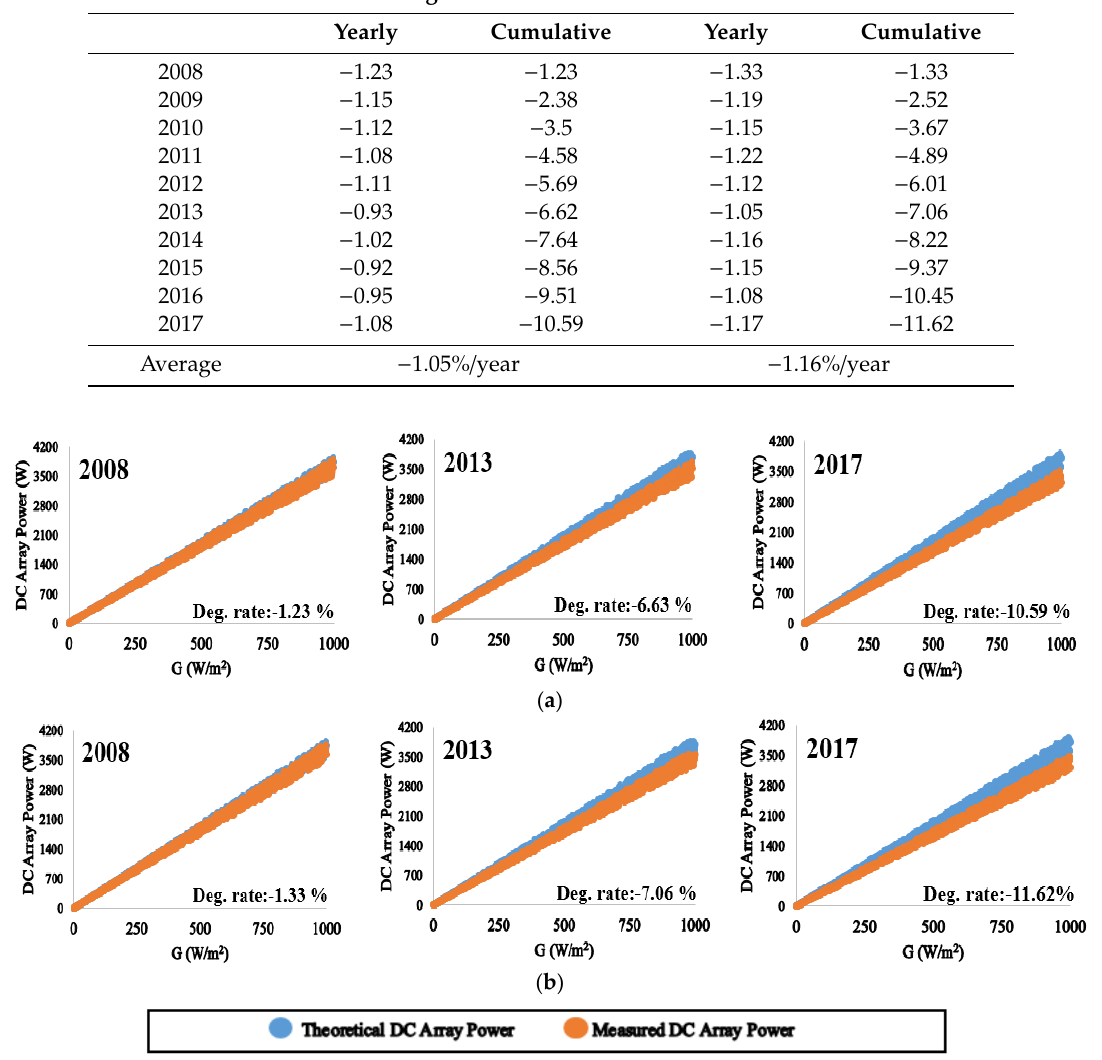
Figure 3. Cumulative degradation rates for PV systems D and E in 2008, 2013, and 2017: ( a ) PV site D—Glasgow; ( b ) PV site E—Aberdeen.